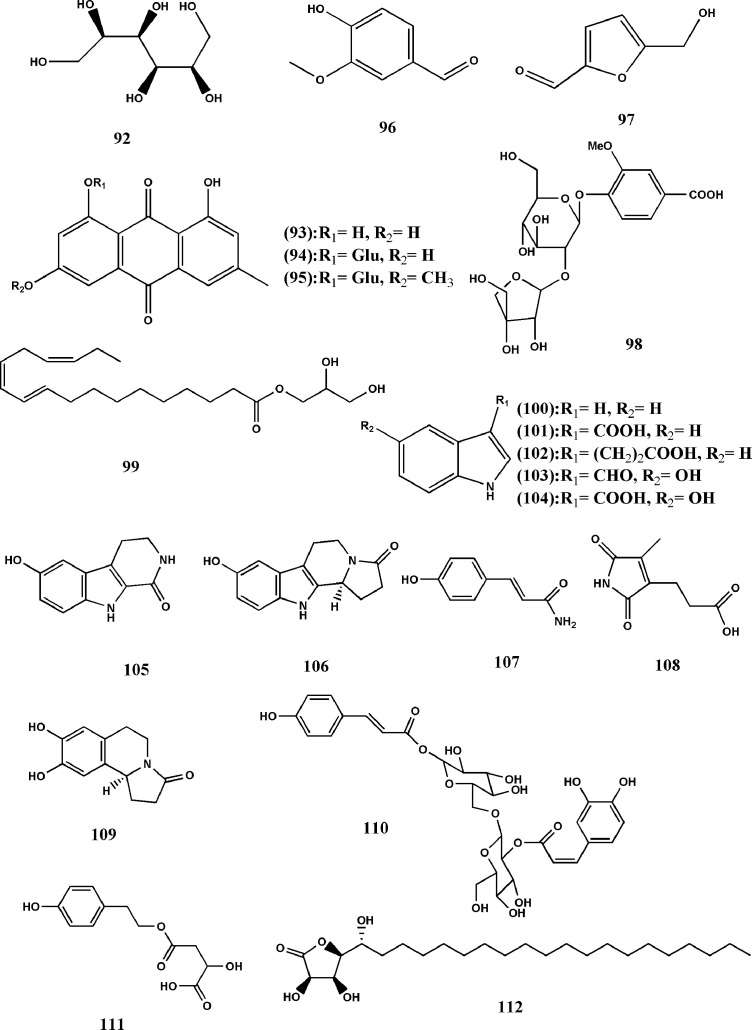
Structures of the anthraquinones, alkaloids, and other components from Tetrastigma hemsleyanum Diels & Gilg. m Tetrastigma hemsleyanum Diels & Gilg.